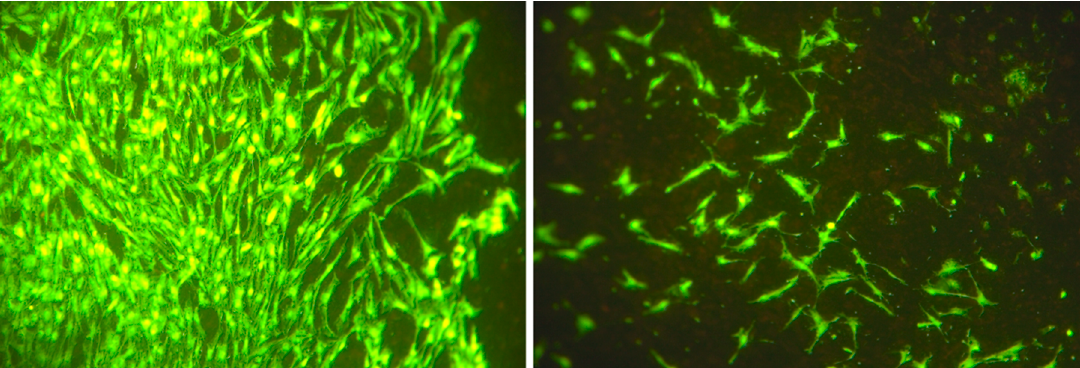
Figure 3. Evaluation of cell number and cellular surface coverage of adipose-derived stem cells electrically stimulated (left) and non-stimulated (right) at day 3 (original magnification ×100).